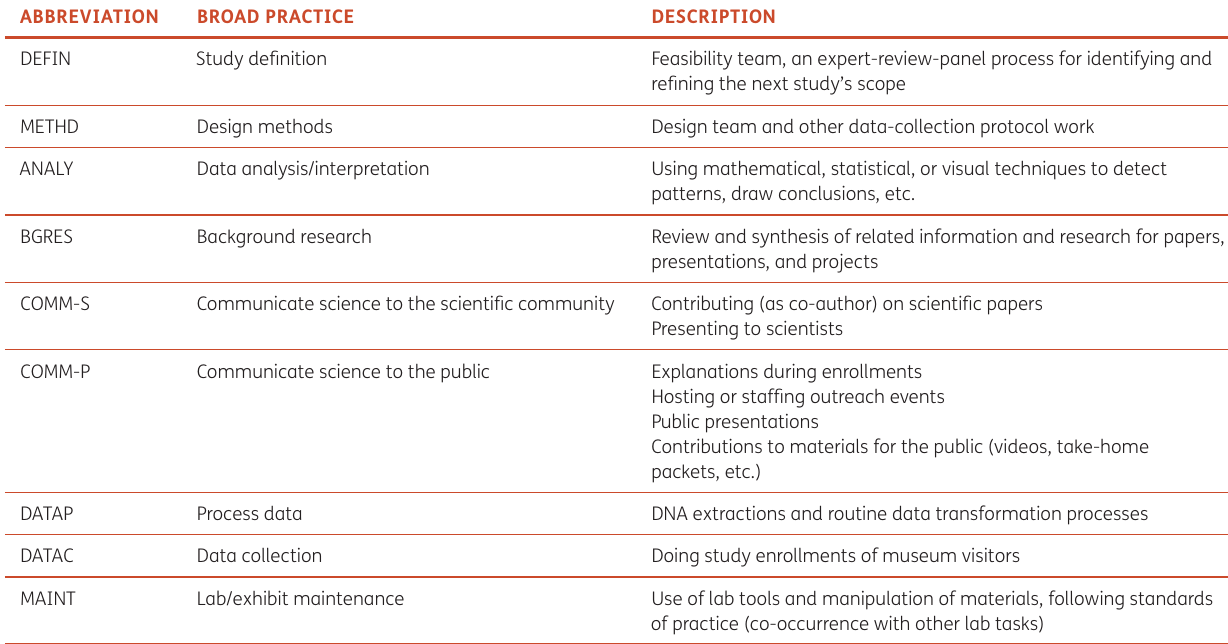
Table 2 Community science lab practice codes and